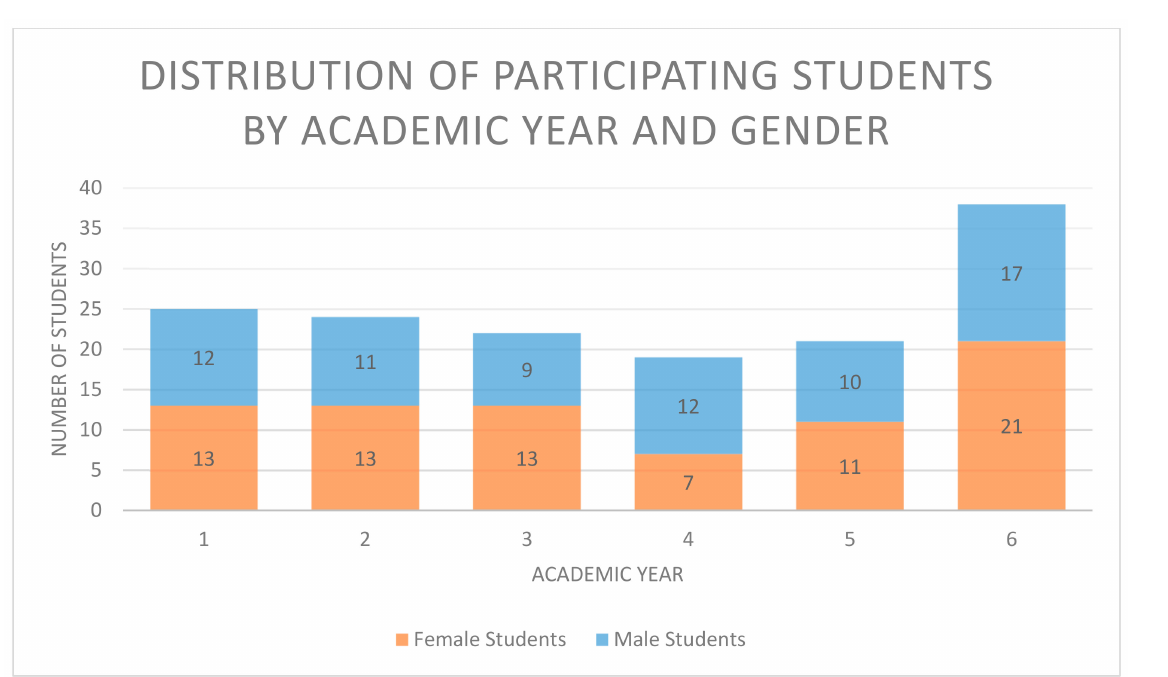
Figure 1. Total number of participating students by academic year and